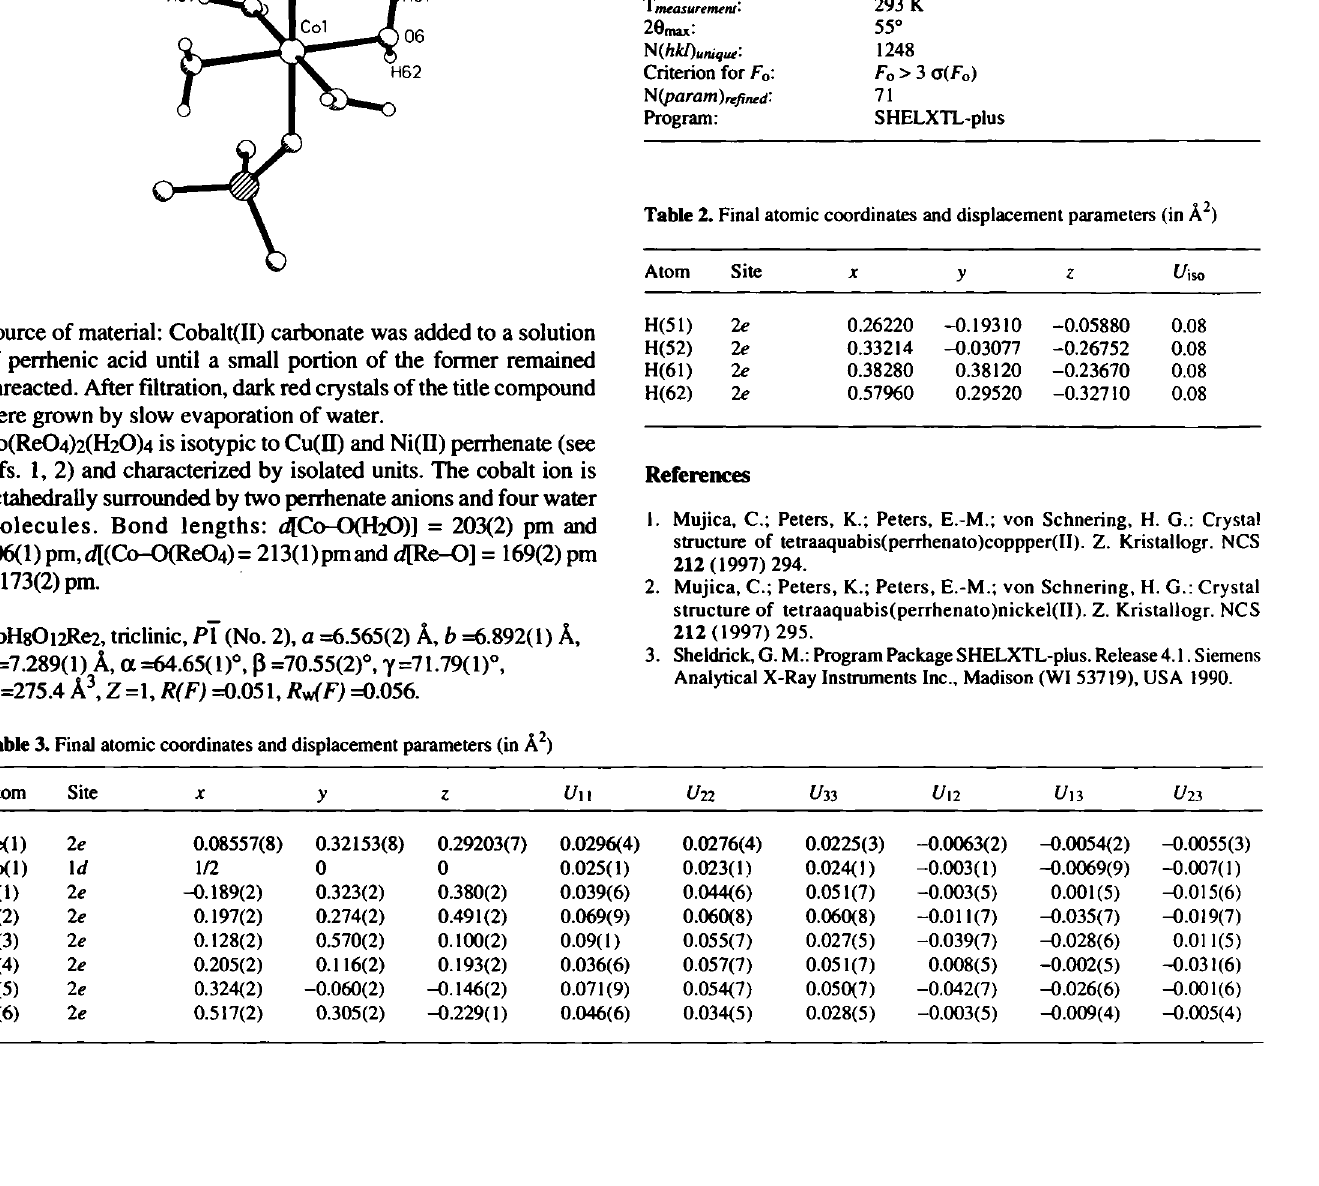
Table 1. Parameters used for the X-ray data collection